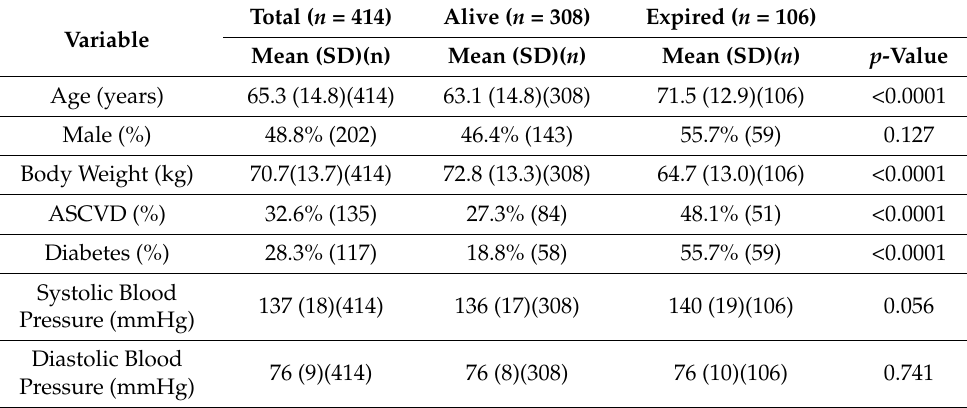
Table 1. Patients’ characteristics according to study cohort and status at study